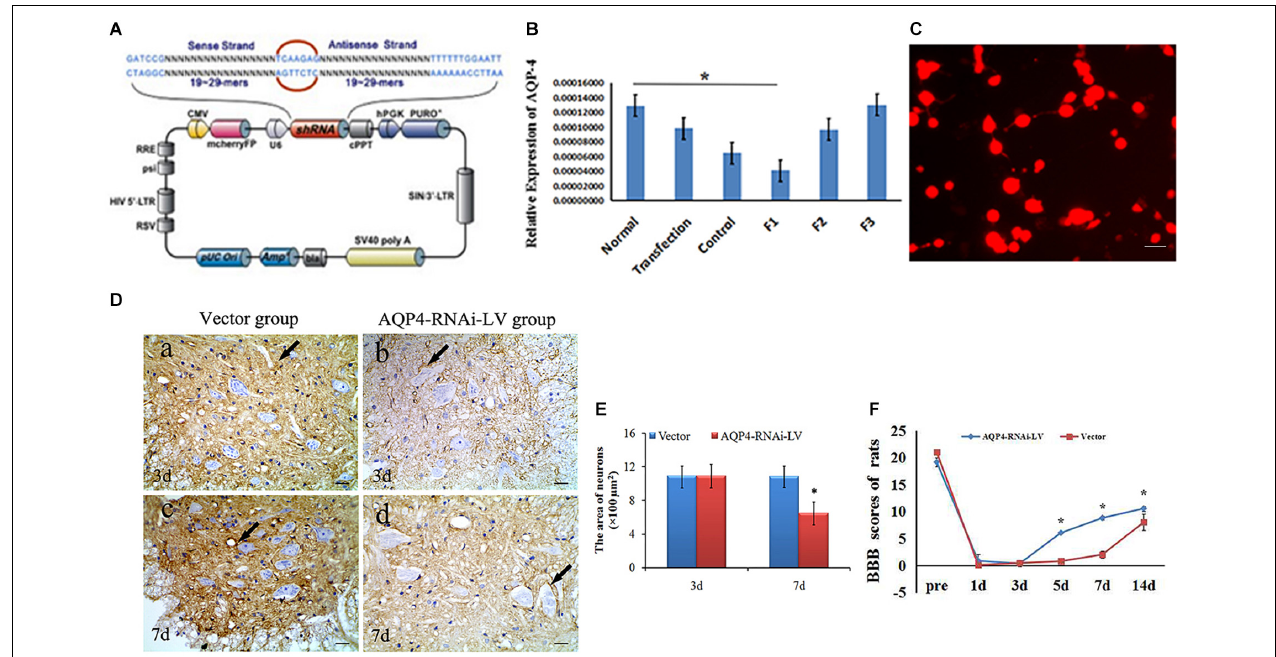
FIGURE 3 | Preparation and identification of AQP4-RNAi-LV recombinants. (A) The schematic of the AQP4 siRNA sequence is shown. Enhanced red fluorescent protein (mcherryFP) as a reporter gene was inserted in the plasmid. The framework also contained the antibiotic ampicillin and pUC Ori promoters for vector expression. (B) qRT-PCR showed F1 was the most effective interference of AQP4. ∗ P < 0.05 when compared to control group. (C) Fluorescent image of AQP4-RNAi-LV (red) transfected into 293T cells. (D) Immunohistochemistry shows the AQP4 immunoreactive products in the vector group and the AQP4-RNAi-LV group. Panel (D-a) shows AQP4 immunoreactive products in spinal cords of the vector group, and Panel (D-b) shows the AQP4 immunoreactive products in spinal cords of the AQP4-RNAi-LV group. It is clear that the degree of color in the vector group was stronger than the AQP4-RNAi-LV group, which suggests that the AQP4 interference affected the expression of AQP4 in vivo . Bar = 100 µ m. (E) The area of neurons was measured by ImageJ, and the data showed that the area of neurons in the AQP4-RNAi-LV group was significantly decreased compared to the vector group at 7 days. ∗ P < 0.05 when compared to vector group. (F) The BBB scores in the AQP4-RNAi-LV group were significantly higher than in the vector group at 5, 7, and 14 days ( n = 6, P < 0.05). Values are expressed as mean ± SEM ∗ P < 0.05 when compared to vector